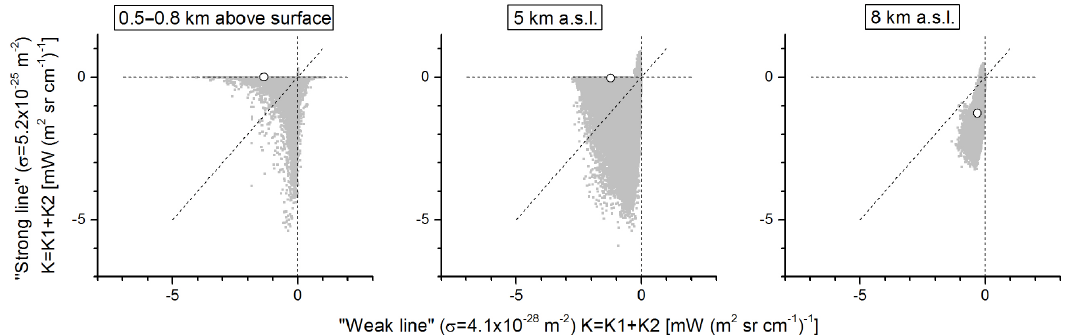
Figure 3. Relation between the Jacobians ( K i,j = K 1 i,j + K 2 i,j ) obtained for the two different line strength and the three different altitudes from Fig. 2. The left panel is for the boundary layer (about 500 to 800m above surface), the middle panel for 5kma.s.l., and the right panel for 8kma.s.l.; The black circles filled by white colour indicate the results obtained for the surface and atmospheric conditions corresponding to the averaging kernels of Fig.